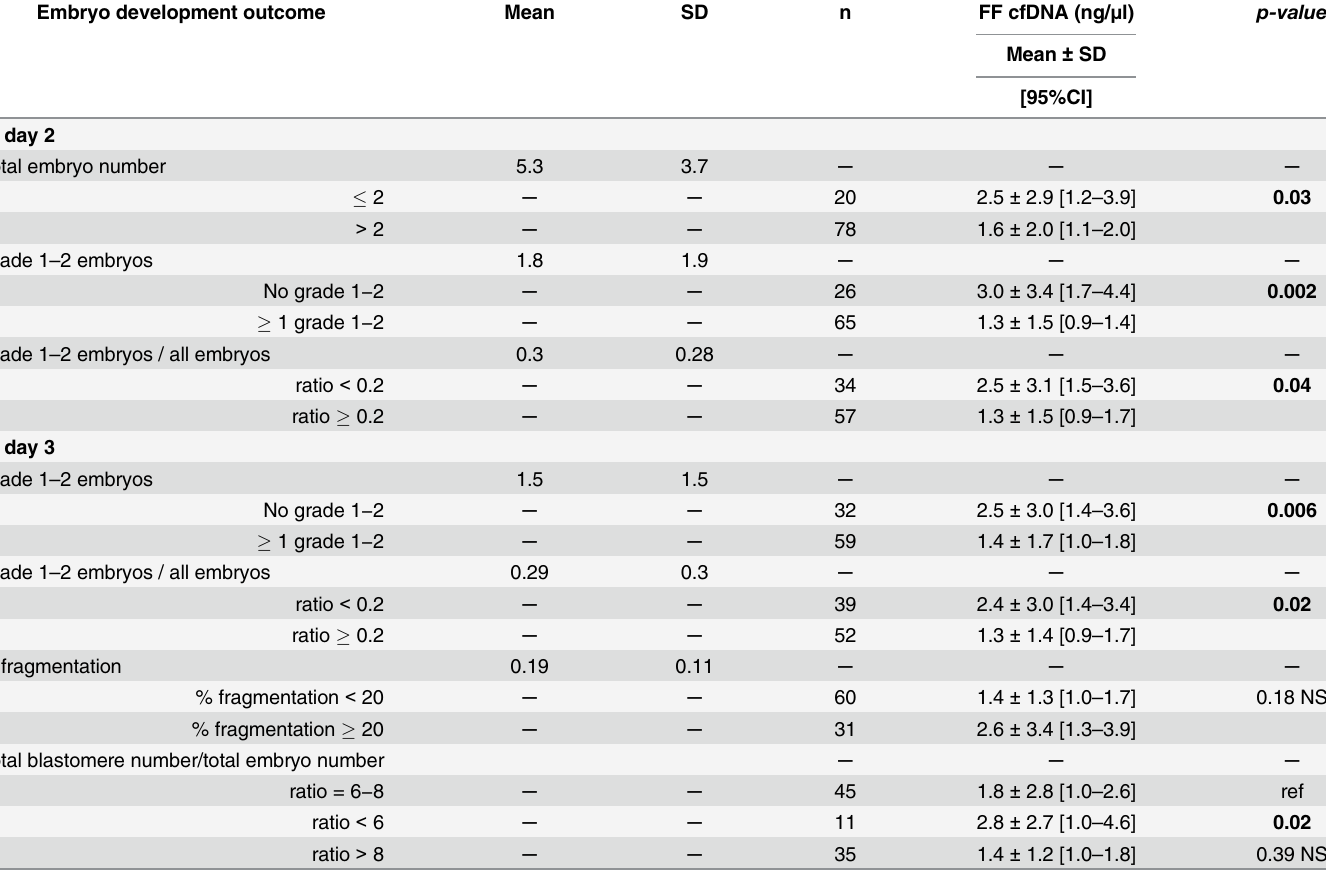
Table 3. Cell-free DNA levels in follicular fluid pools according to the embryo development outcome at early stages (day 2 and day 3). Embryo development